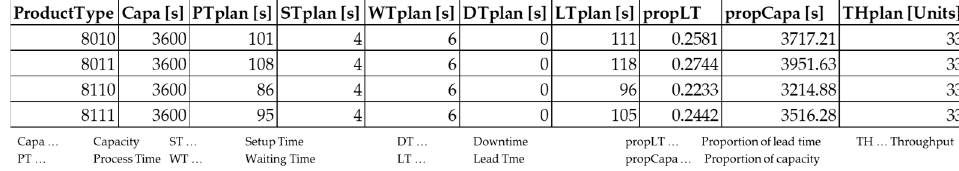
Figure 12. Data to create the initial production schedule for test series one.